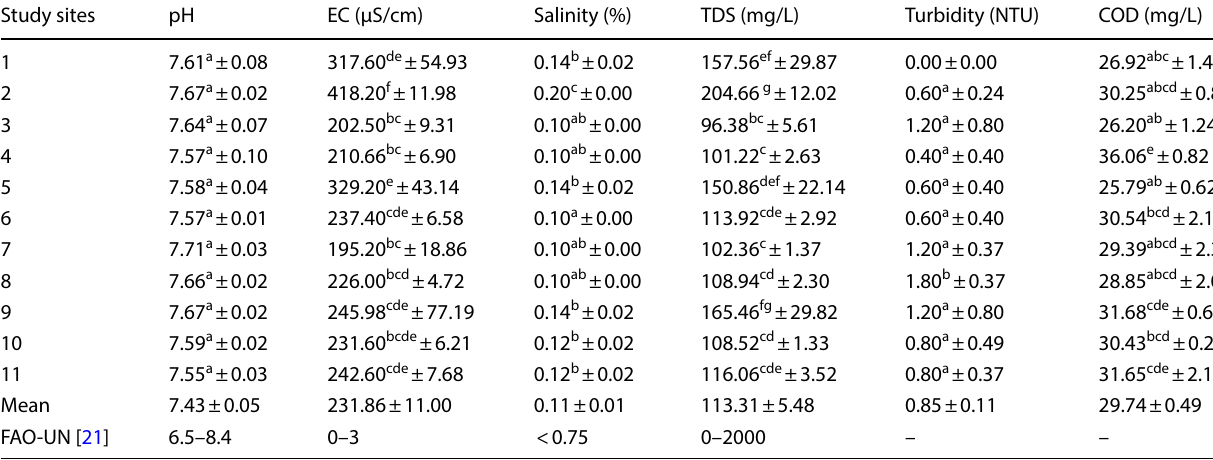
Table 1 Physico-chemical properties of irrigation water from cold desert high-altitude trans-Himalayan region